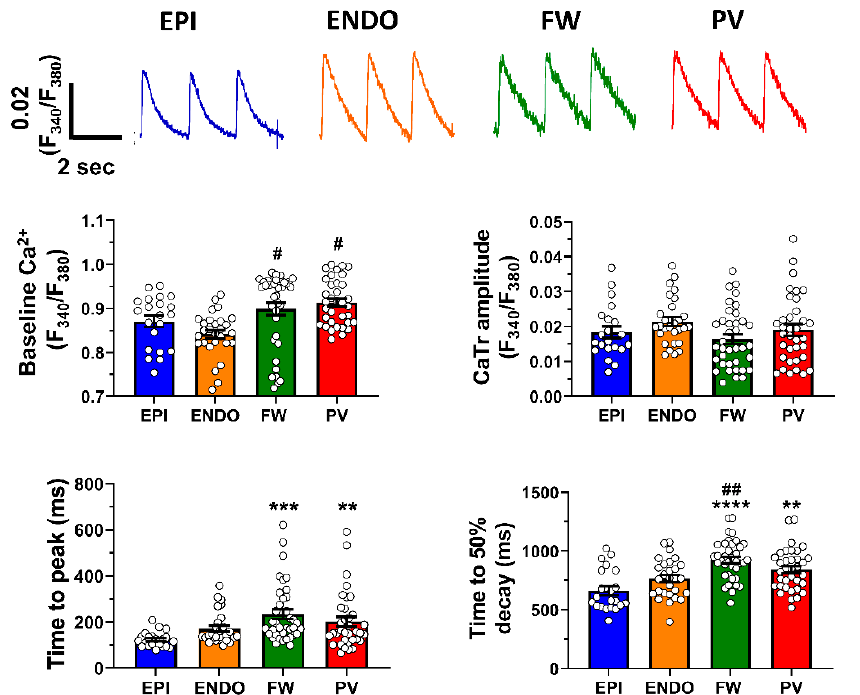
Figure 1. Ca 2+ transient heterogeneity in left atria from sheep. Top panel shows representative Ca 2+ transient (CaTr) recorded at 0.5 Hz in adult sheep cardiac myocytes isolated from the epicardium (EPI) and endocardium (ENDO) regions of the left appendage (blue and orange traces, respectively); the free wall region (FW) and the pulmonary vein (PV) region of the left atrium (green and red traces, respectively). Lower panel is Mean ± SEM diastolic Ca 2+ , CaTr amplitude, time to peak and time to 50% transient decay recorded in those four atrial regions. n = 21, 28, 37 and 35 cells for EPI, EnNDO, FW and PV groups, respectively. Data are represented as mean ± SEM with ** p < 0.01, *** p < 0.001, **** p < 0.0001 compared to EPI and # p < 0.05, ## p < 0.01 compared to ENDO.